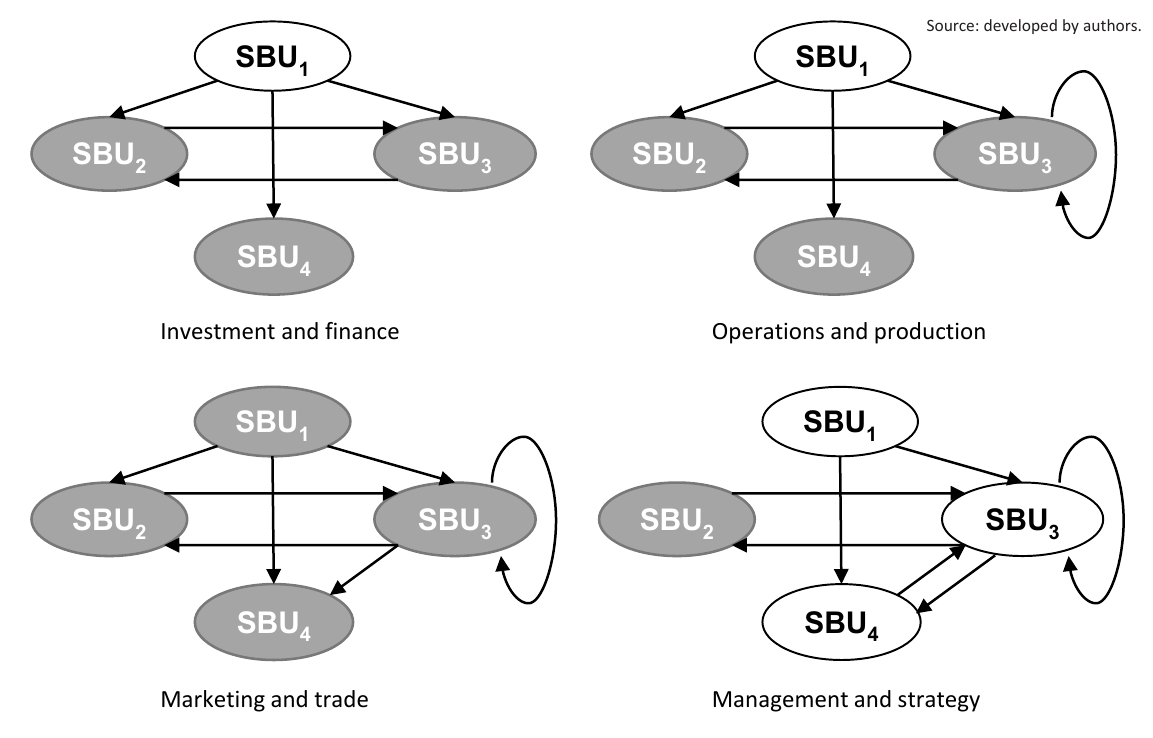
Figure 3. SBUs’ interaction diagrams according to interaction